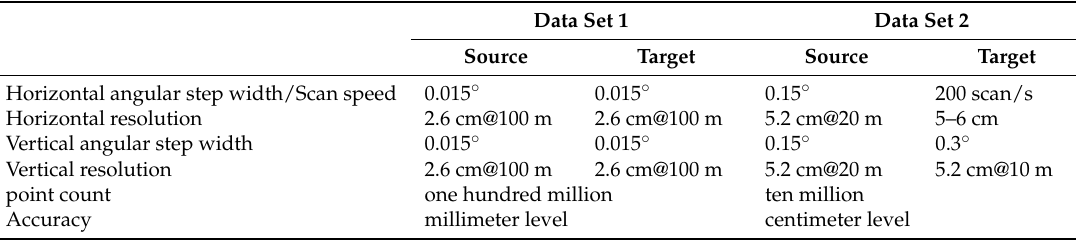
Table 2. The comparison of the two test datasets.